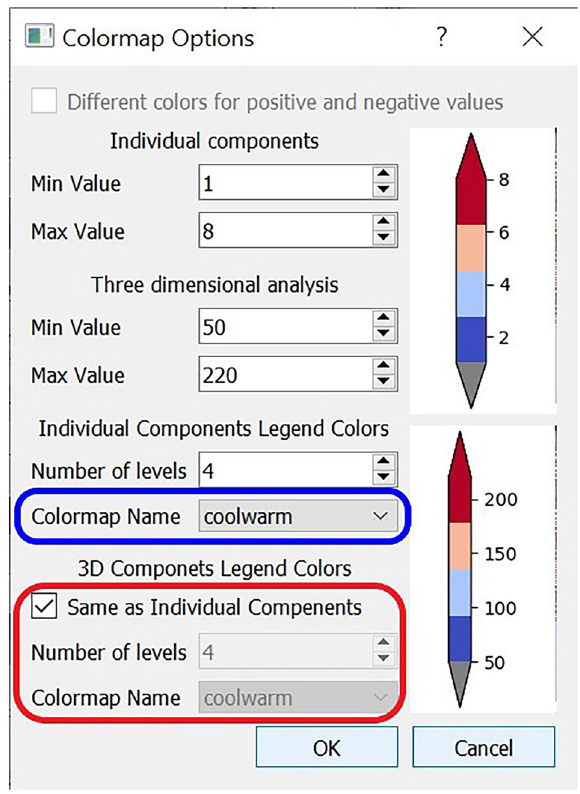
Figure 5. Color Scale dialogue.